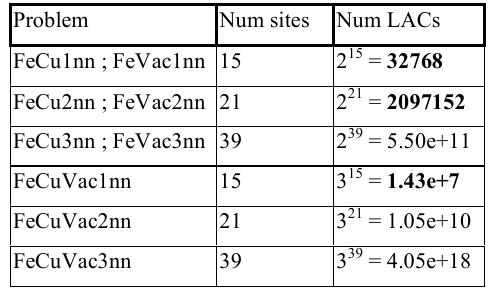
Table. 1. Problems of interest for our application. The bold values in the last column are those for which a full calculation with MD and tabulation is feasible. As an order of magnitude, one VME calculation with MD takes about one minute on modern personal